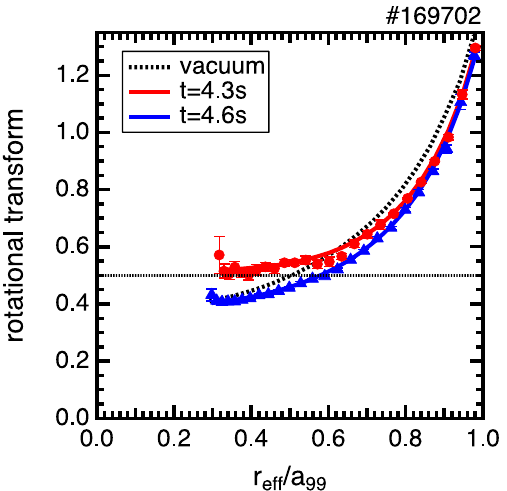
Figure 2. Rotational transform profiles before ( t = 4.3 s, red) and after ( t = 4.6 s, blue) the change in the direction of current drive. Additionally, the black dotted line shows the rotational transform profile in a vacuum magnetic field. The black horizontal line denotes a rotational transform value of 0.5.